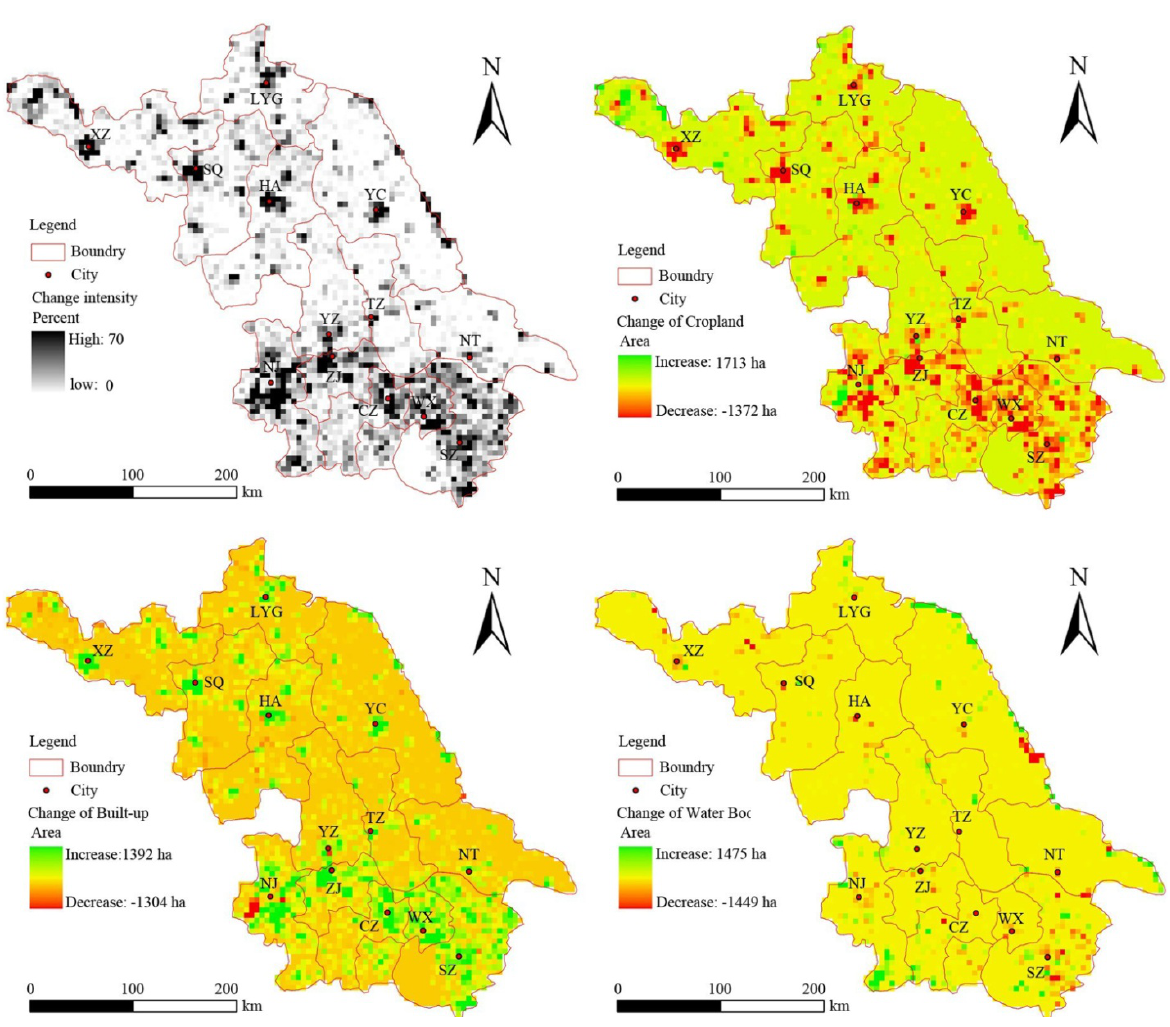
Figure 5. Spatial distribution of land use change from 2005 to